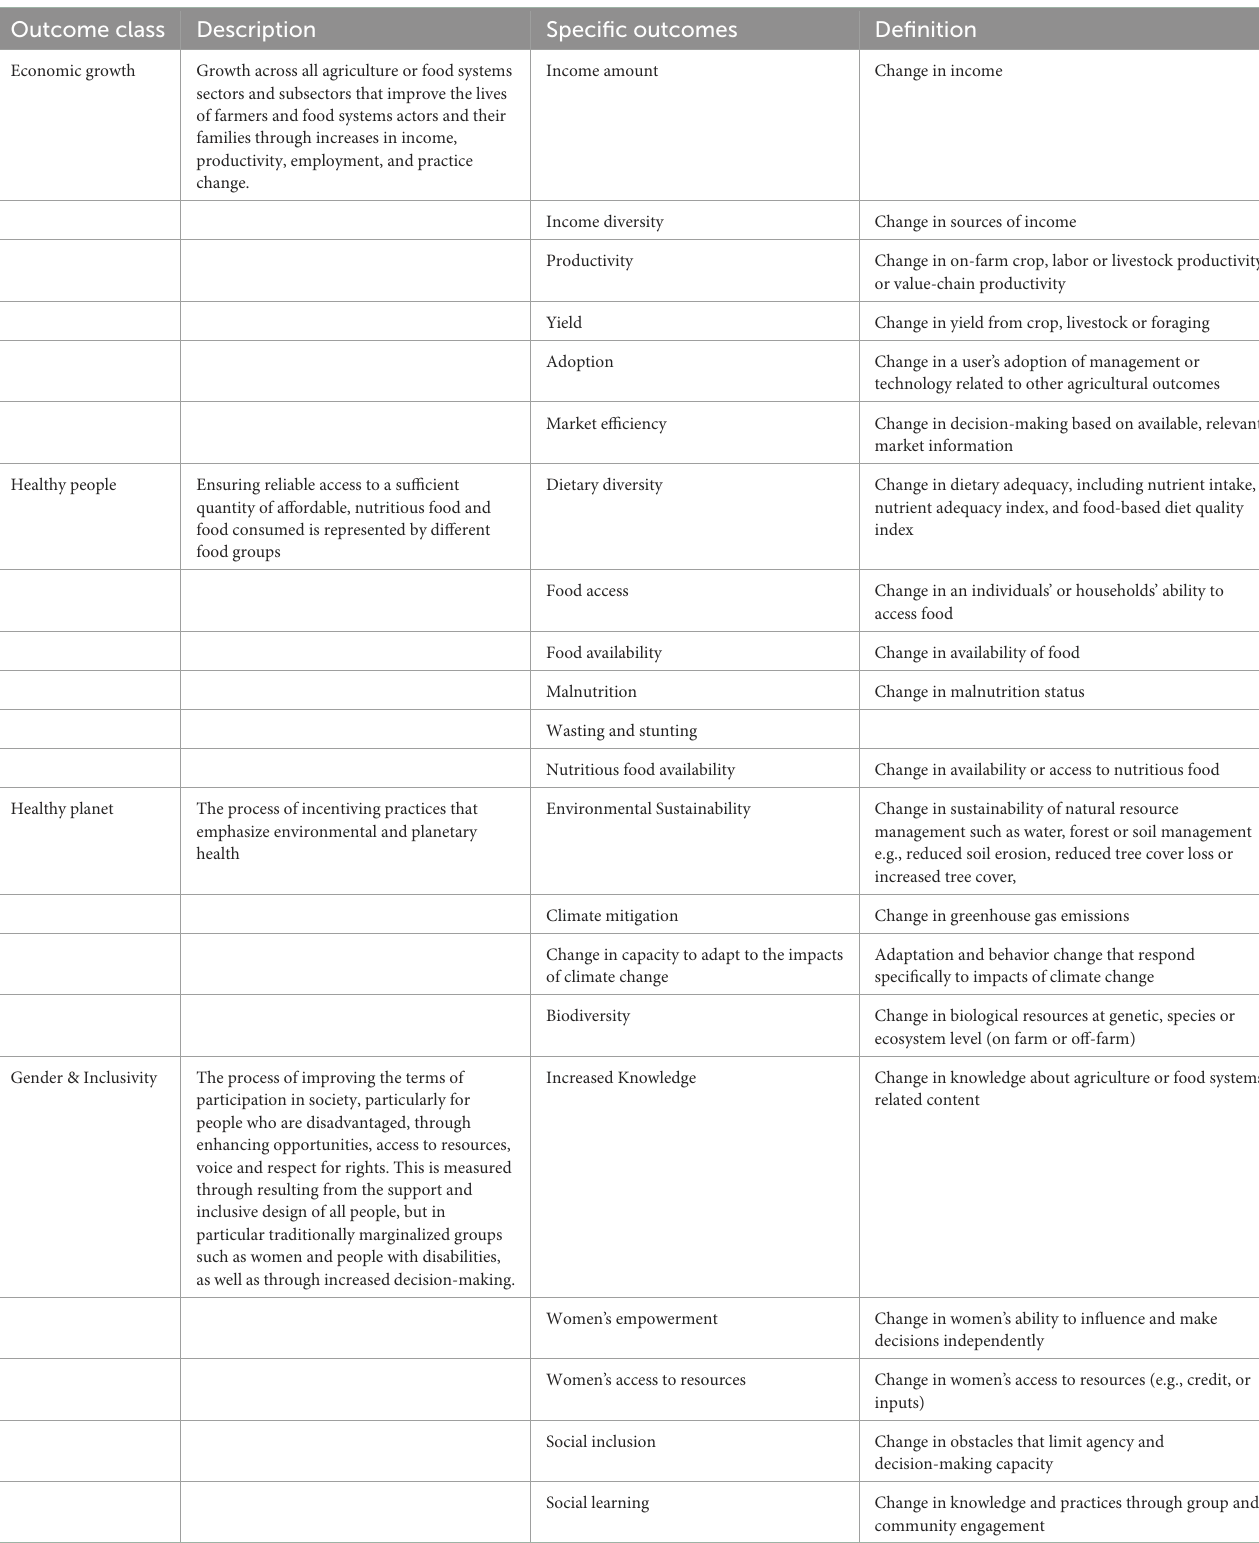
TABLE 1 Outcomes, descriptions and